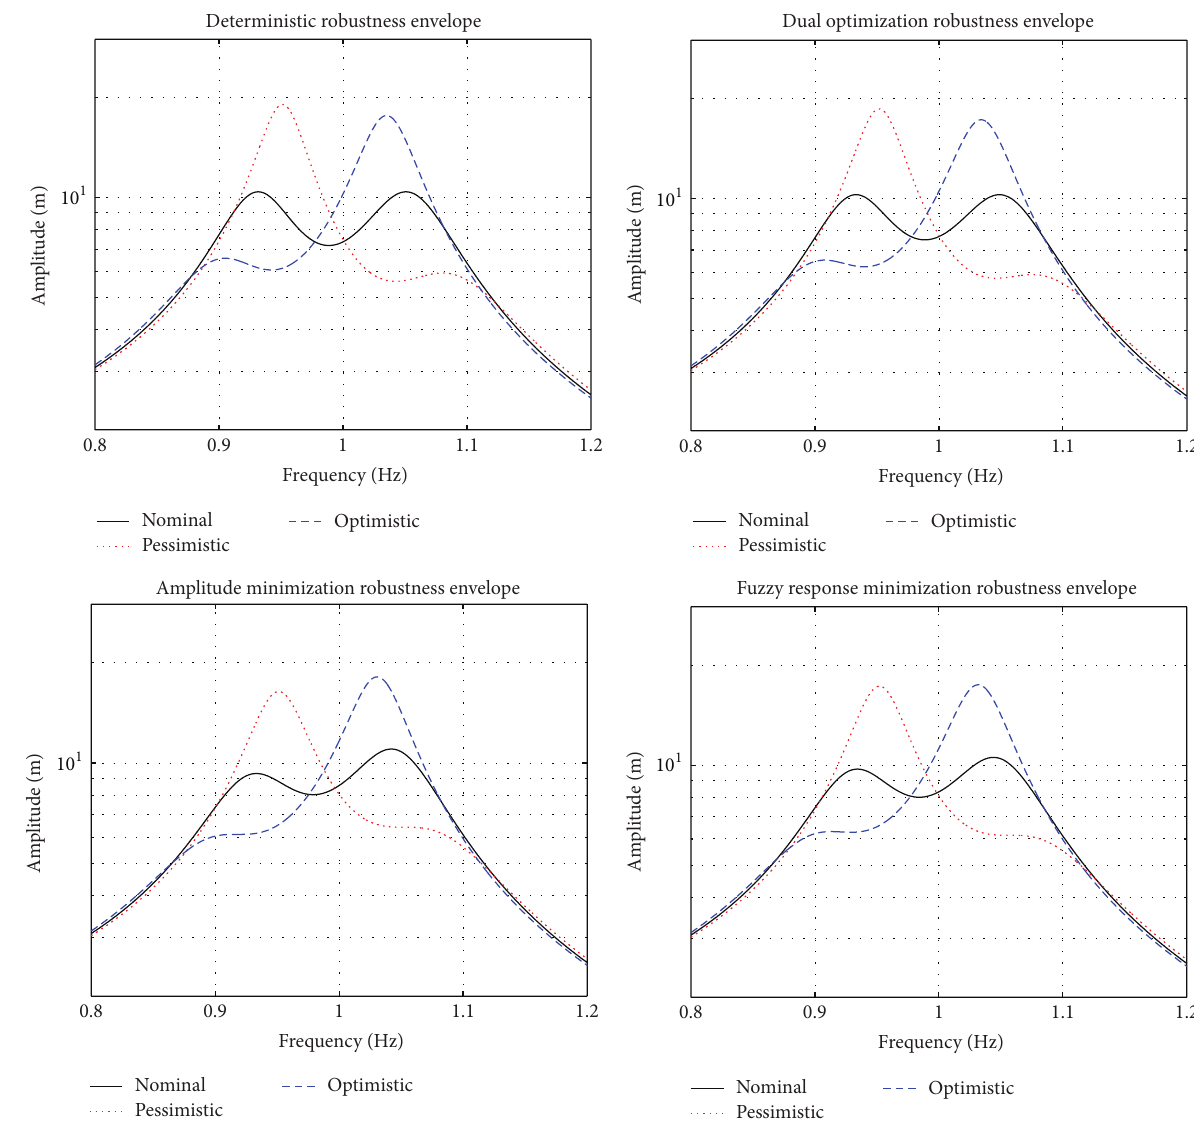
Figure 9: Robustness envelopes determined in the design of the